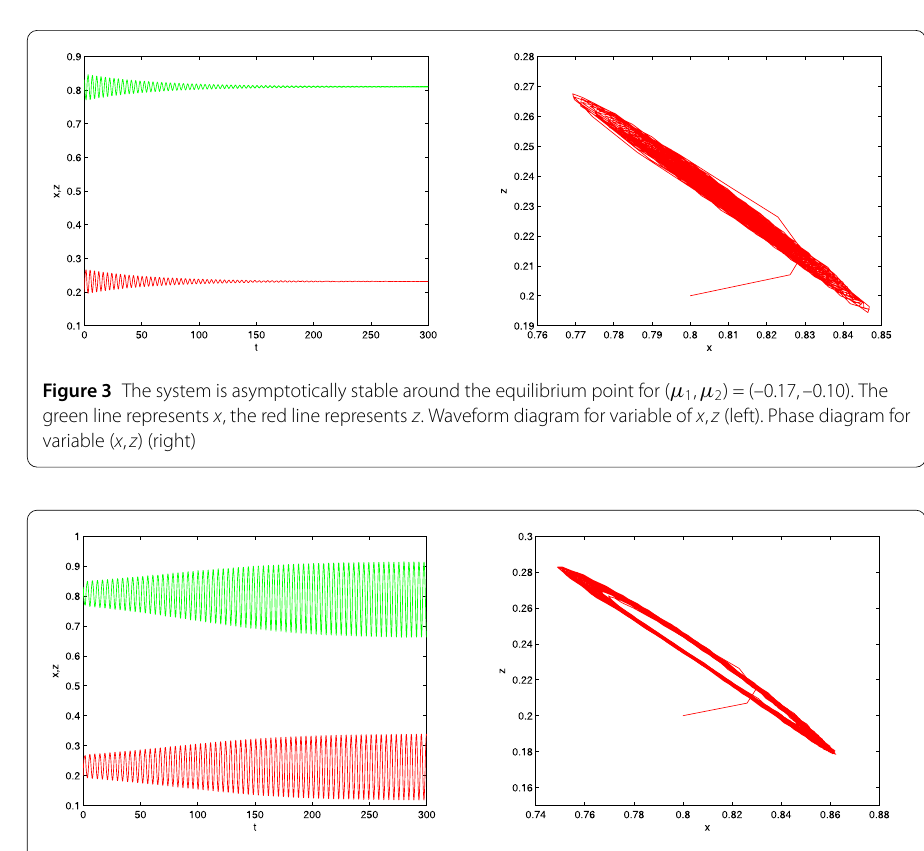
Figure 4 The system has an asymptotically stable periodic orbit near τ 1 for ( μ 1 , μ 2 ) = (0.11,0.10). The green line represents x , the red line represents z . Waveform diagram for variable of x , z (left). Phase diagram for variable ( x , z )